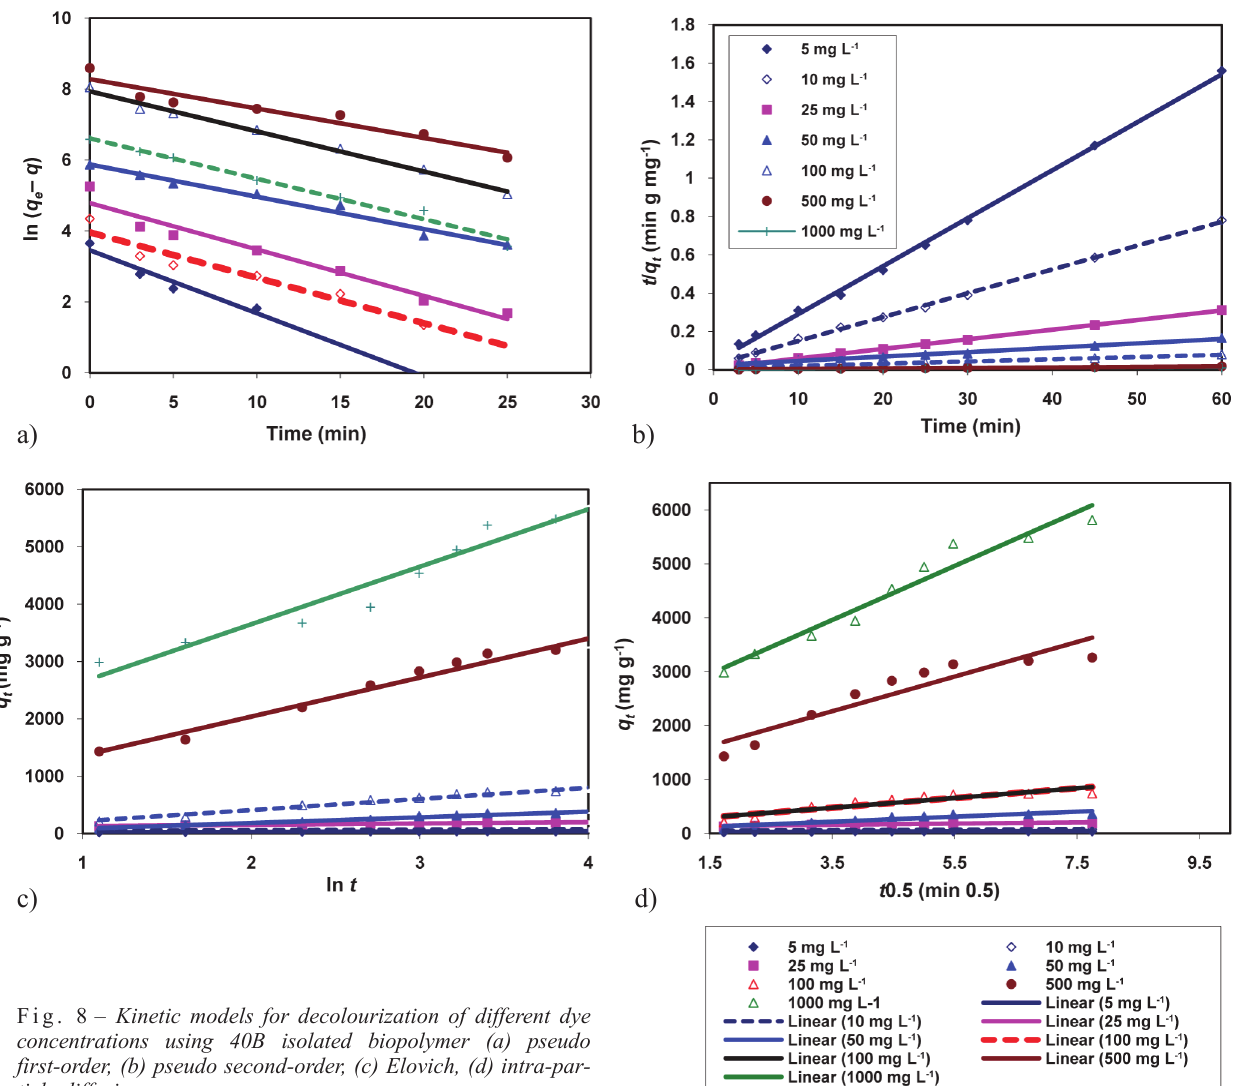
Fig. 8 – Kinetic models for decolourization of different dye concentrations using 40B isolated biopolymer (a) pseudo first-order, (b) pseudo second-order, (c) Elovich, (d) intra-par- ticle